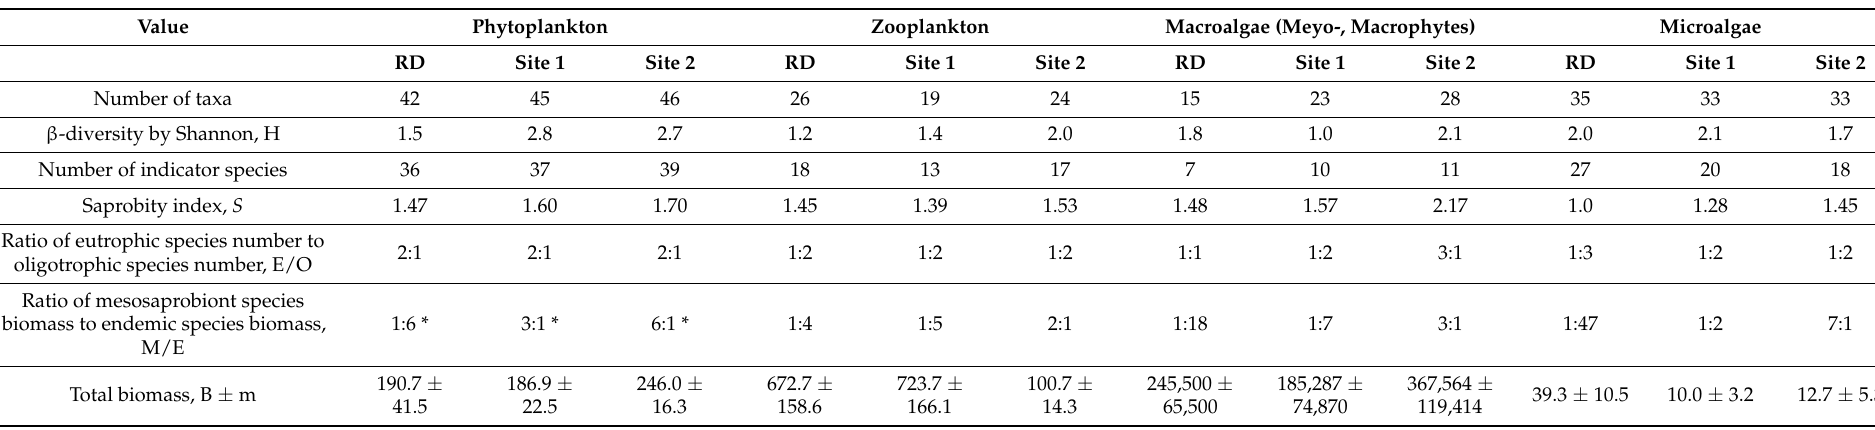
Table 3. The trophic level of the study area in the coastal zone of Lake Baikal (August 2016): RD—reference data, Site 1—background area, Site 2—area with human activity in Listvennichny Bay; *—ratio of flagellates biomass to endemic species biomass; B—average biomass (mg) for phyto- and zooplankton per m 3 , for macro- and microalgae per m 2 ; m—standard error. Value Phytoplankton Zooplankton Macroalgae (Meyo-, Macrophytes) Microalgae Number of taxa β -diversity by Shannon, H Number of indicator species Ratio of eutrophic species number to oligotrophic species number, E/O Ratio of mesosaprobiont species biomass to endemic species biomass, M/E 190.7 ± Total biomass, B ± m